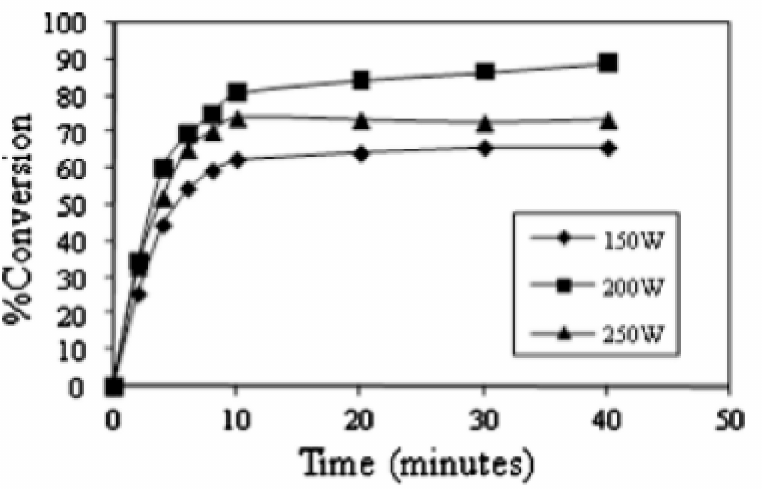
Figure 6. Effect of ultrasonic power dissipation on the extent of conversion of biodiesel Reproduced with permission from Hingu et al., Synthesis of biodiesel from waste cooking oil using sonochemical reactors, Elsevier, 2010